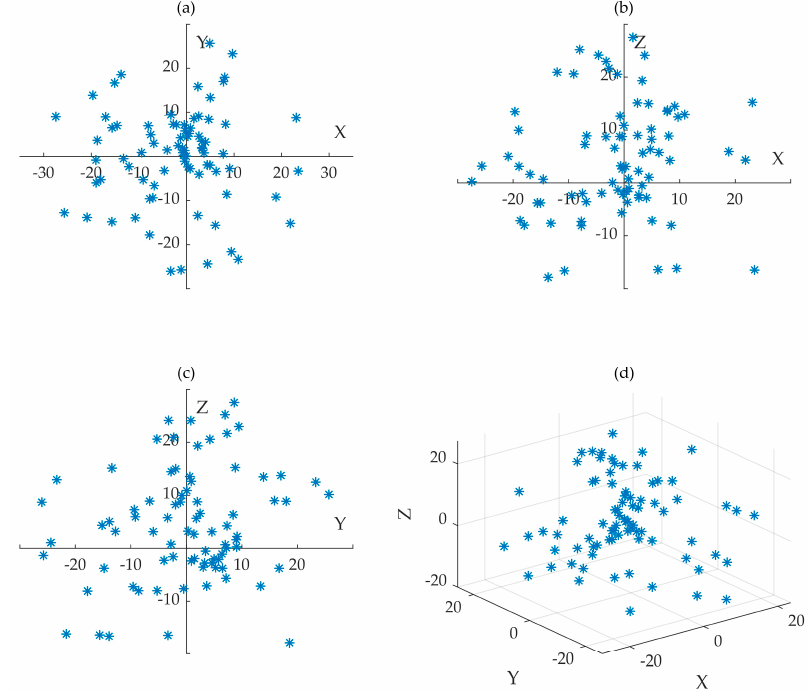
Figure 3. Distribution of point cloud Cartesian coordinates in the TLS system. ( a ) Projection to X-Y plane; ( b ) Projection to X-Z plane; ( c ) Projection to Y-Z plane; ( d ) Cartesian coordinate system.